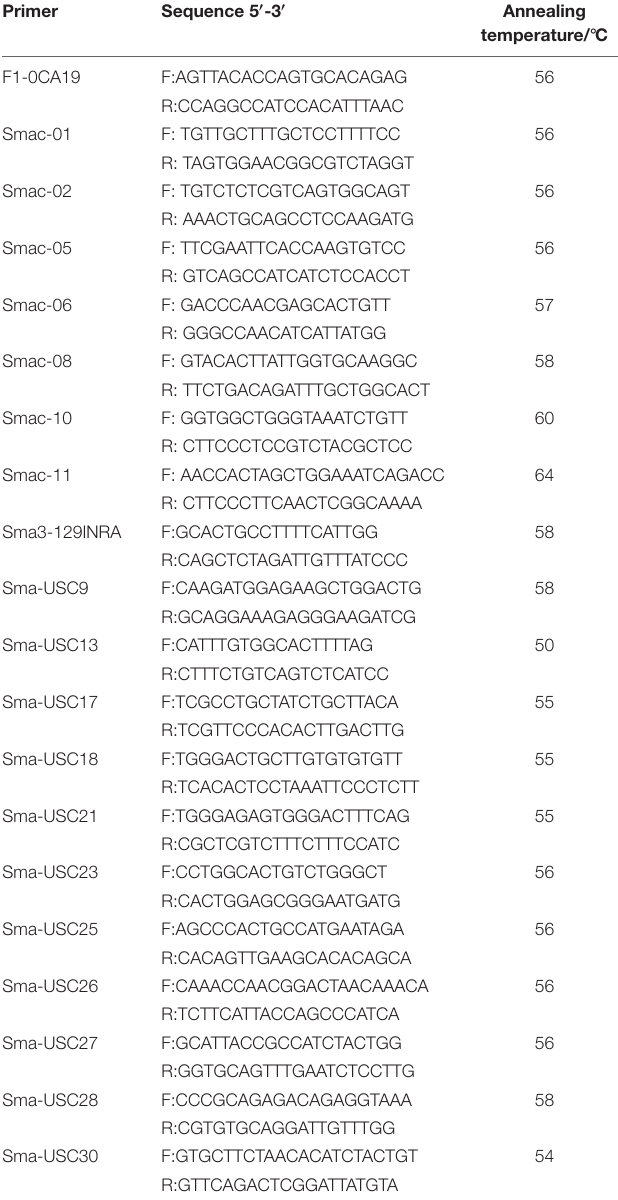
TABLE 1 | The microsatellite primer and annealing